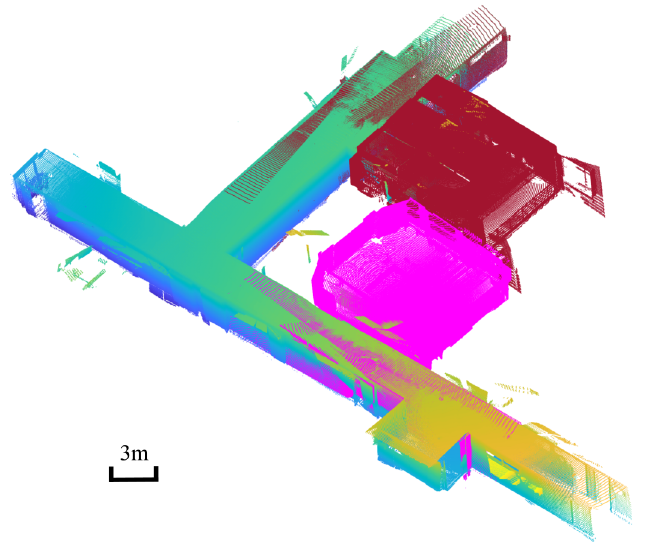
Figure 13. The registration result of scenario 1, which is an L-shape corridor with one room located on each edge. Two indoor models are colored in magenta and claret red separately. Several outdoor point clouds in scenario 1 were registered as a unified outdoor model, and the corresponding outdoor models for two scenes are colored in the same color as their indoor models.